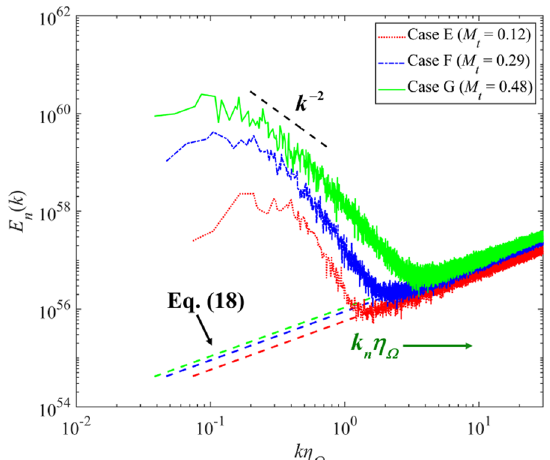
3 . The spectra of thermal =